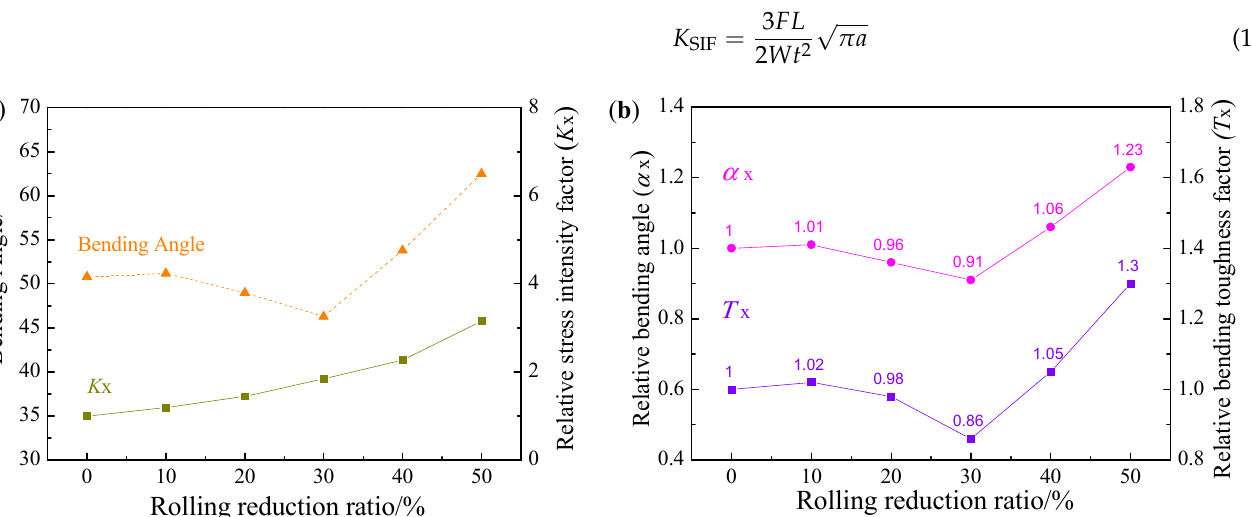
15 of 18 Figure 17. Lap shear strength testing of AS60/60 coating at different reduction ratios at TAUS = 930 °C for 5 min. The lap shear strength was 22.35 ± 1.20 MPa in the original AS60/60 coatings, and was 22.25 ± 1.40, 21.60 ± 1.15, 22.10 ± 1.15, 22.40 ± 1.30, 21.80 ± 1.40 MPa respectively in the AS60/60 coatings from 10% to 50% reduction ratios (Figure 9a). The failure type and shear strength were consistent between the two original and reduced coatings, indicating the strength did not change with the variation of cold rolling reduction ratio. The surface roughness of the austenitized AS60/60 coatings at different cold rolling reduction ratios was shown in Figure 9b. The surface roughness of the austenitized coat- ings was larger than that of the cold-rolled coatings, but decreased as the cold rolling re- duction ratio rose. In the austenitized coatings, high-density intermetallic compounds were formed, and the coating volume was contracted, leading to an increase in the surface roughness of the coatings [30]. As the cold rolling reduction ratio rose, the coating thick- ness decreased, and the volume decreasing rate of the corresponding austenitized coat- ings declined. As a result, as the cold rolling reduction ratio increased, the surface rough- ness of the austenitized coatings decreased. 3.3. Bending Toughness of Al-Si Coated PHS The results of bending angle of PHS at different reduction ratios after austenitization were shown in Figure 18a. The bending angle gradually decreased with the rise of cold rolling reduction ratio in the range ≤ 30%, but rapidly increased at the reduction ratio ≥ 40%. The bending angle at the reduction ratio of 50% was enlarged by 23% from that at the reduction ratio of 0%. During the bending deformation, the diffusion layer cannot pre- vent crack expansion in the coatings. Based on three-point bending tests, we suppose there was only one crack at the center of the top bending surface. Thus, for the coating crack that ran through the Al-Fe layer and the diffusion layer, its tip stress intensity factor K SIF was calculated by Equation (1), where F is the applied force, L is the distance between two supports, W and t are the width and thickness of a specimen, respectively, and a is the crack length. Since the cracks run through the Al-Fe layer and the diffusion layer, a is the total thickness of the coating [28]. For PHS specimens cold-rolled at different reduction